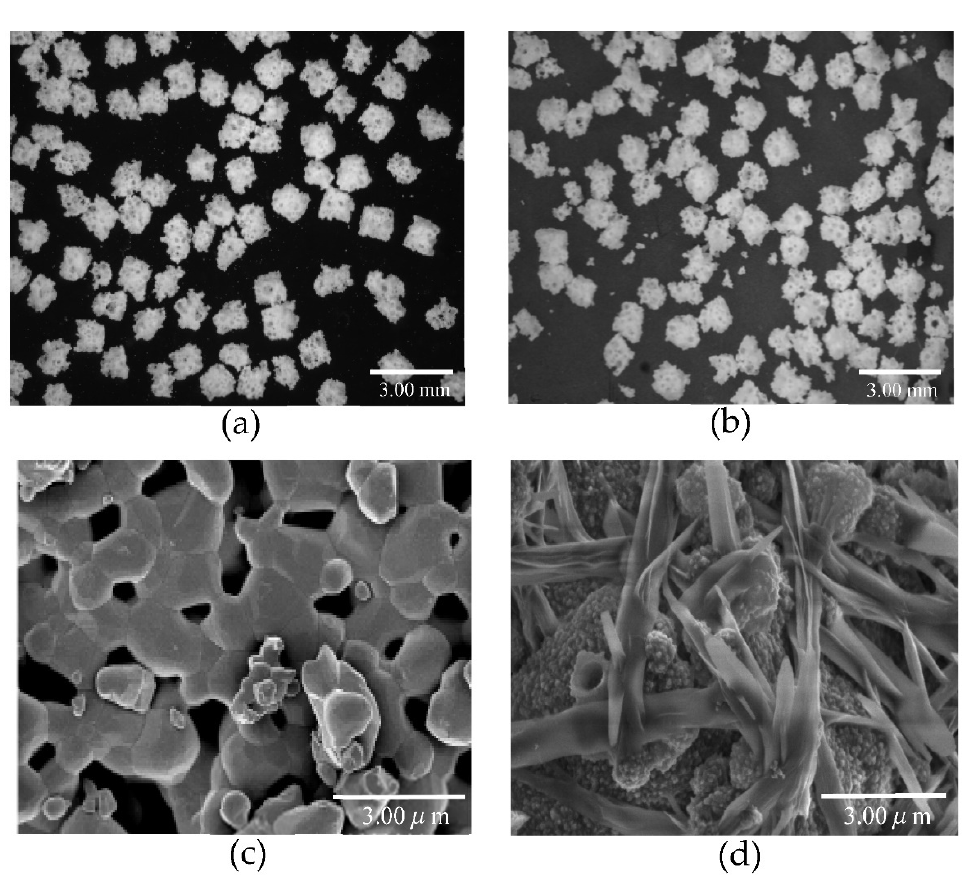
Figure 7. Stereo microscopic and SEM images of HA granules. ( a ): Stereo microscopic image of HA granules. ( b ): Stereo microscopic image of biphasic HA granules. ( c ): SEM image of HA granules. ( d ): SEM image of biphasic HA granules.